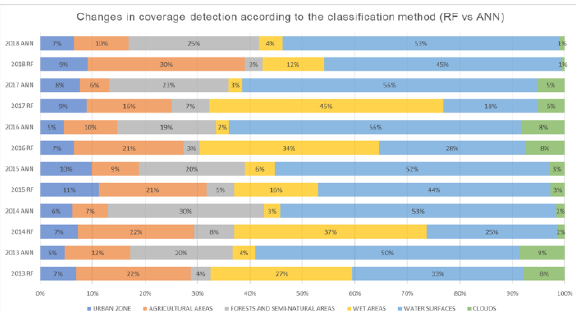
Fig. 5. Percentage of coverage changes with respect to the total study